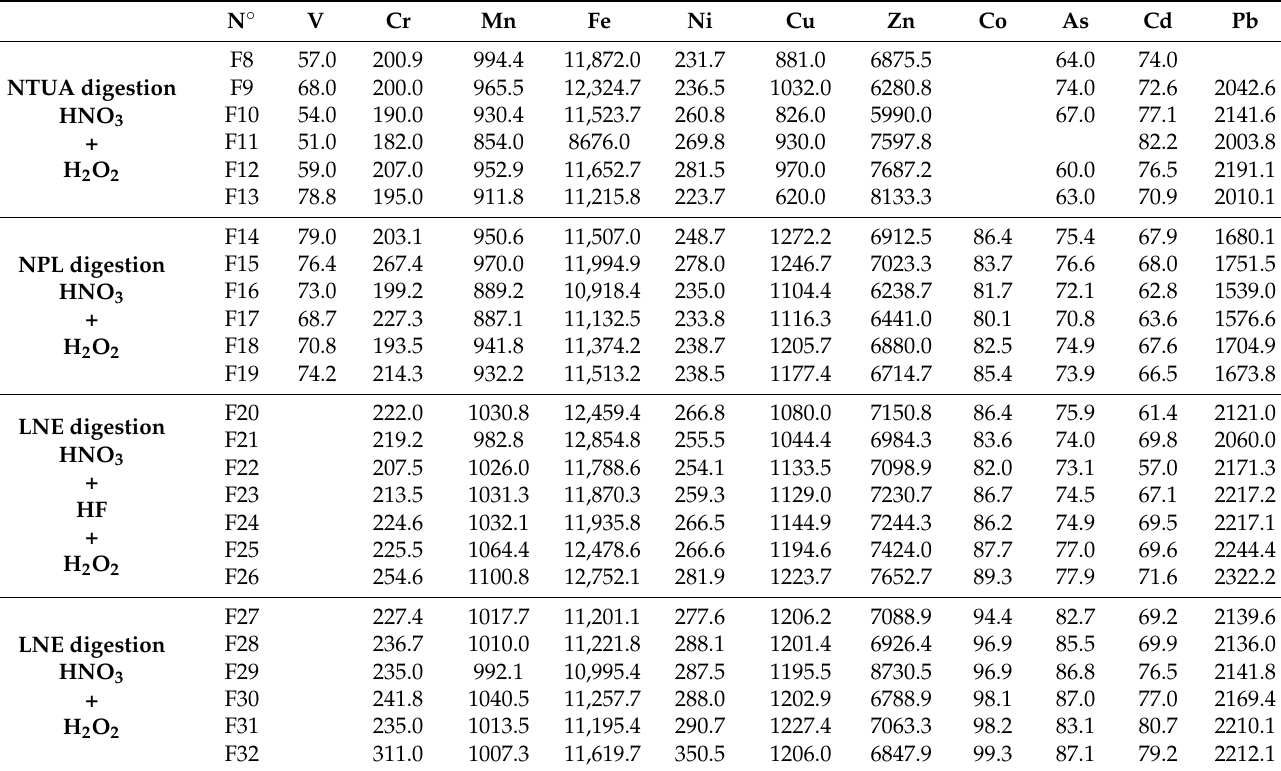
for the PM 10 filters. The RSD are below 15%. Table A2. Metals concentrations (in µ g · g − 1 of deposited materials) and % relative standard deviation between all partici- pants for all metals for PM 10